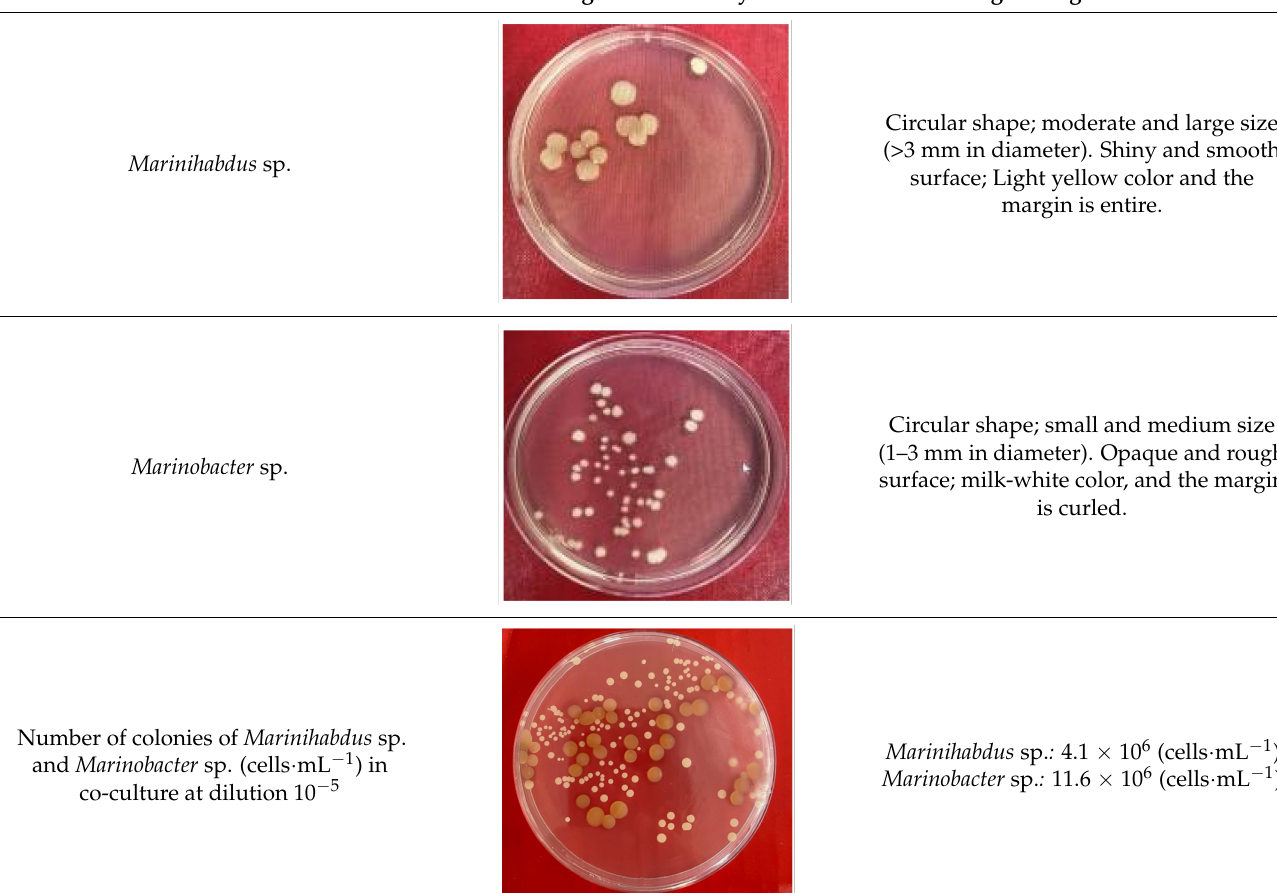
Table 1. Characteristics of recognizably distinct colony types on marine agar plates and relative abundance of the two bacterial strains in the co-culture. Bacteria Image of the Colony Distinguishing Characteristics